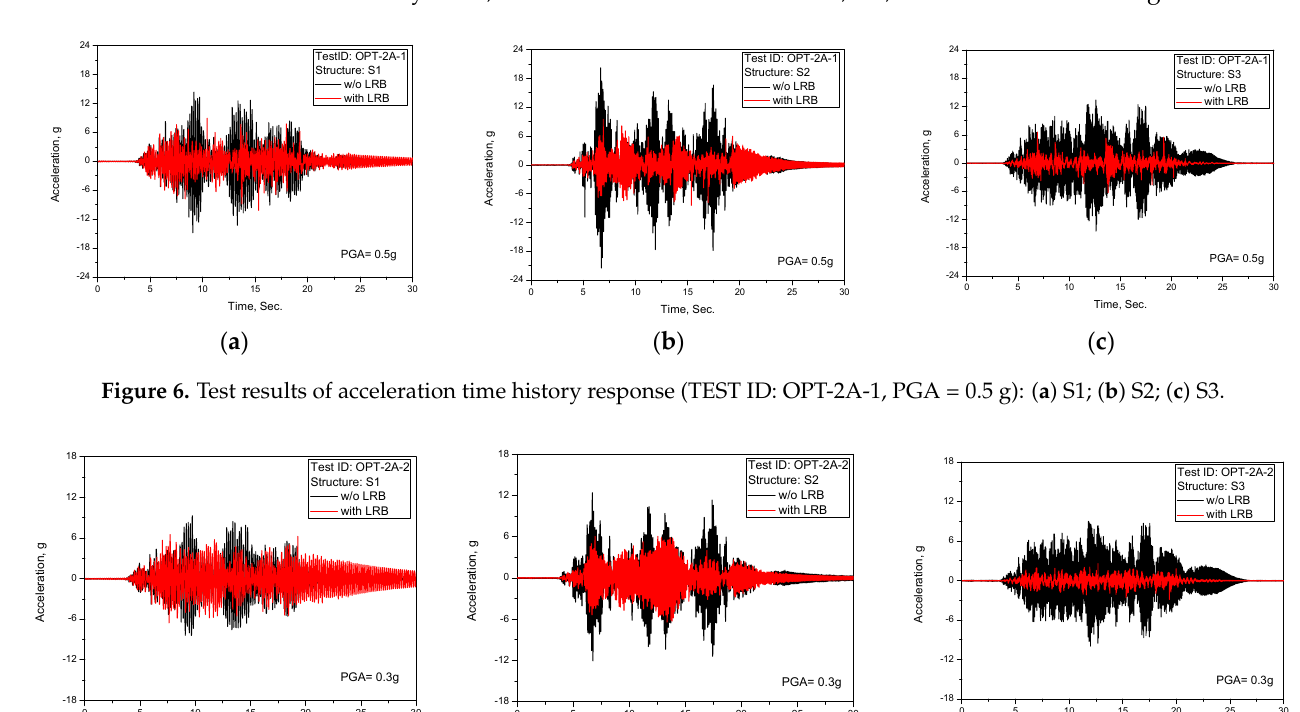
Figure 5. Test results for safe shutdown earthquake (PGA = 0.3 g): ( a ) Acceleration time histories; ( b ) Corresponding re- sponse spectrum.